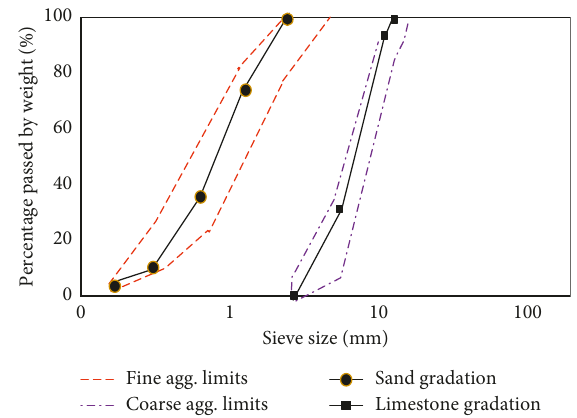
Figure 1: Gradation curves for crushed limestone and river